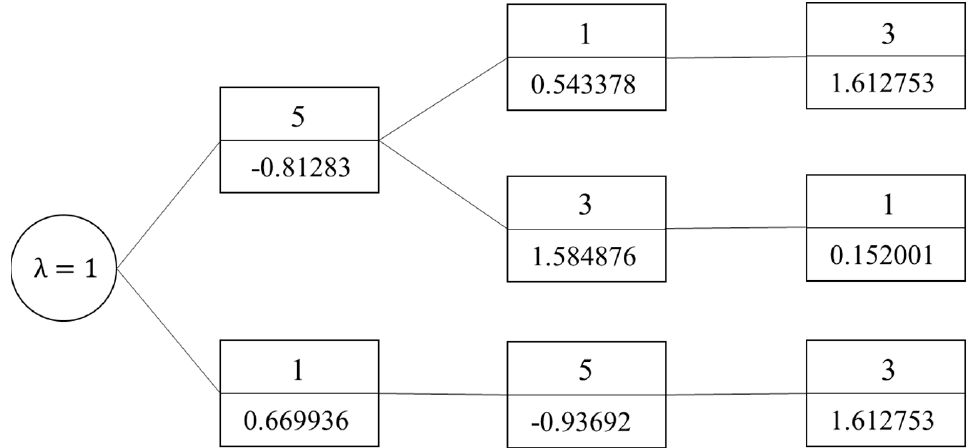
Figure 9. The failure tree and corresponding reliability indices when λ =